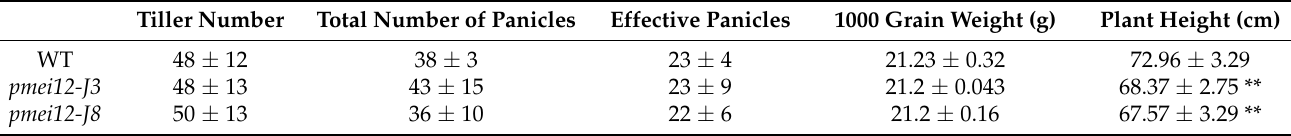
** indicated the significant difference in the traits of pmei12 lines and WT by t -test at p < 0.01 (n = 10).